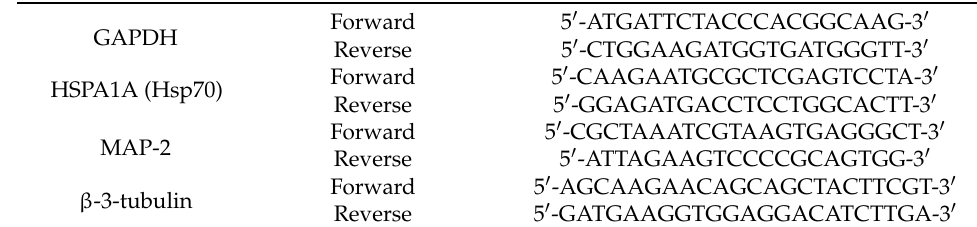
Table 2. Sequences of primers used in the